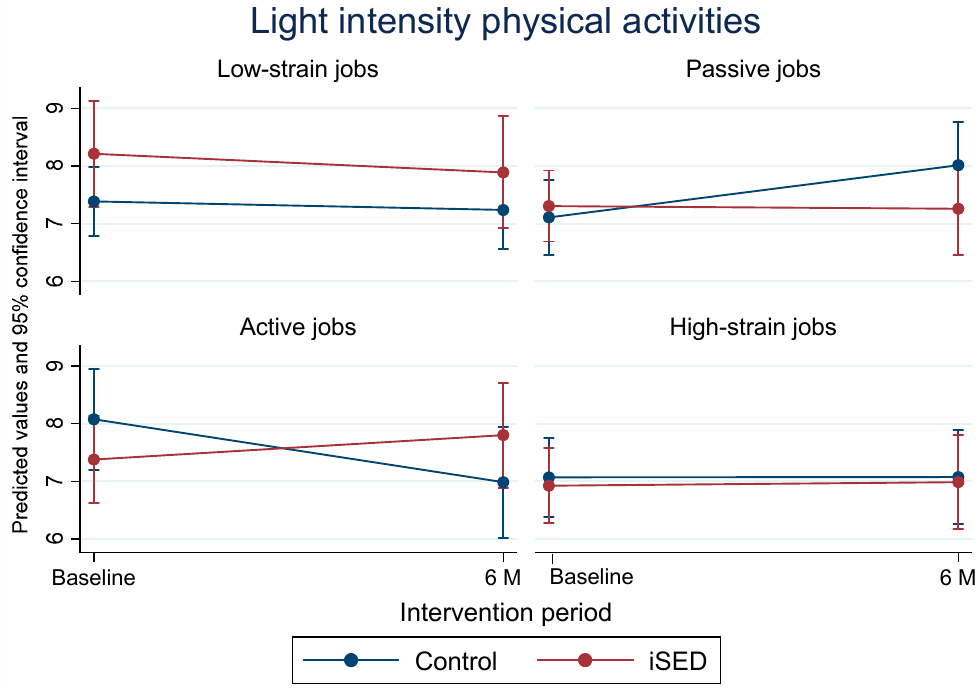
Figure 2. The association of the demand and control model with interventions and changes in light intensity physical activity.